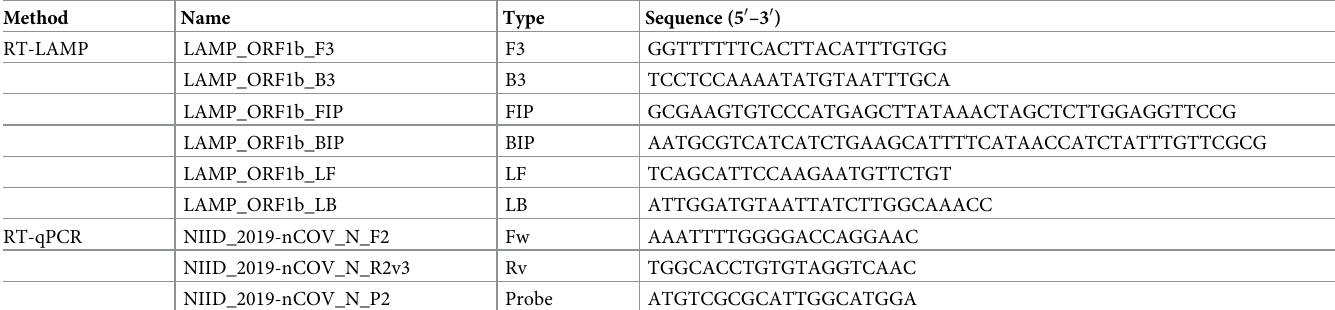
Table 1. Primer sequences used in RT-LAMP and